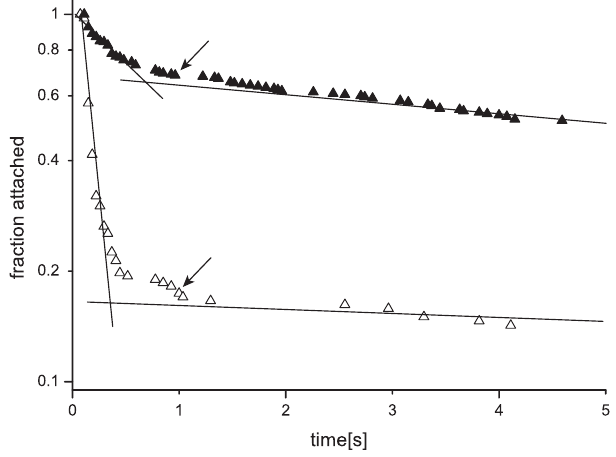
Figure 5. FimH–1M Bond Lifetimes in a Flow Chamber The binding of 1M beads to fimbriae-coated surfaces was monitored in flow chambers at two well-defined flow rates that create drag forces of 2.5 pN (open triangles) and 37 pN (solid triangles) on the beads. Beads moving in the field of view alternately paused (bound to the surface in a stationary manner for a period of time) and moved at the hydrodynamic velocity of the fluid flow. The lifetime of the pauses was measured and assumed to correspond to single-bond lifetimes. The lifetime of these pauses is plotted here as the fraction of all pauses that survive to the time indicated on the x -axis. There are two distinct decay rates under each condition, suggesting a weak and a strong conformational state, each corresponding to short-lived and long-lived binding, respectively. The fraction of pauses lasting more than 1 s (arrows) was calculated directly from raw data like these and used in Figure 4B. This fraction increased with force, consistent with the notion that FimH forms a catch bond with mannose because of a force-induced switch to a long-lived state. The lines correspond to the slopes of the exponential fits of the lifetimes in the first 500 ms or between 2 and 20 s, as described in the Materials and Methods